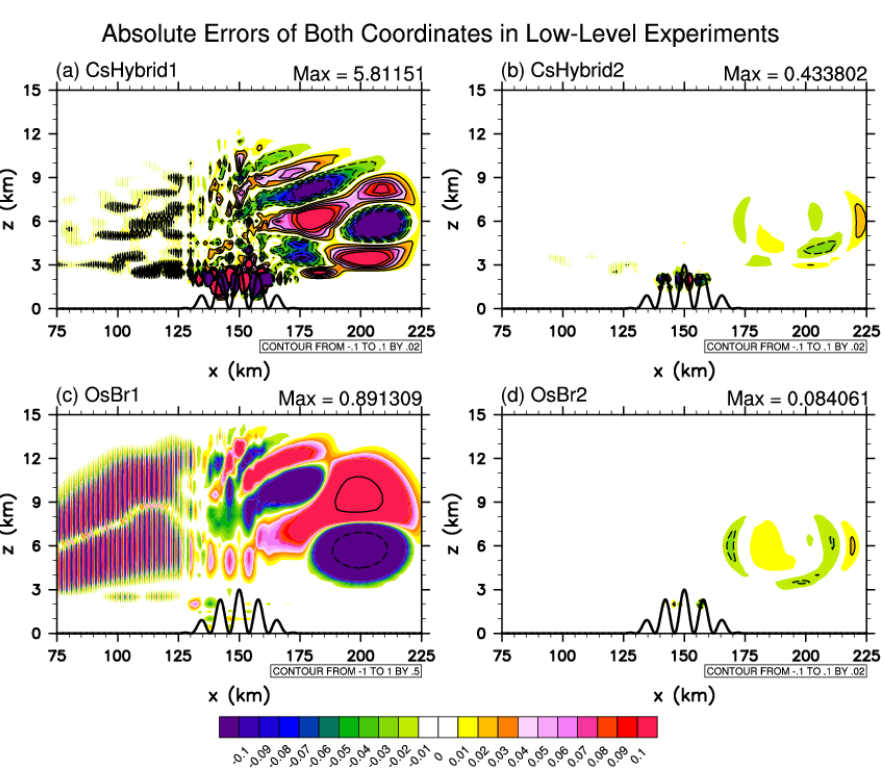
Figure 12. Absolute errors of the hybrid σ coordinate and the OS coordinate compared with the analytical solution in the modified Schär- type (low-level) experiments at the end of the integration. Shading represents the AE. The solid black contours are for positive values, and the dashed contours are for negative values. The contour interval is 0.02 in (a) , (b) , and (d) ; and that in (c) is 0.5. The solid black curve in the bottom of each figure represents the mountain. The values of AE under the surface of the mountain are due to the interpolation of plotting.